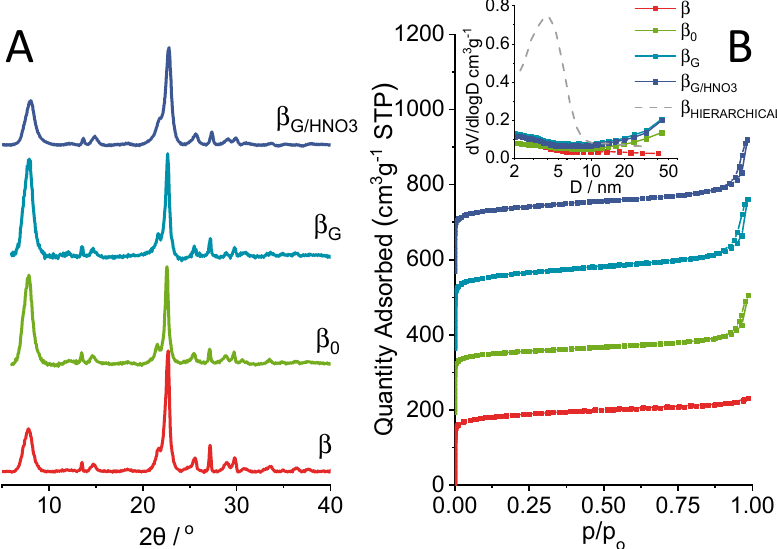
Figure 1. XRD patterns ( A ) and N 2 adsorption–desorption isotherms with pore size distribution (inset) ( B ) of the studied samples ( β HIERARCHICAL sample added for comparison [5]).